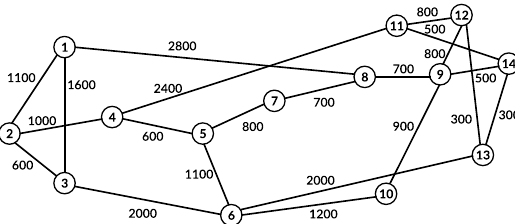
Figure 4. The NSFNET topology with 14 nodes and 21 links.